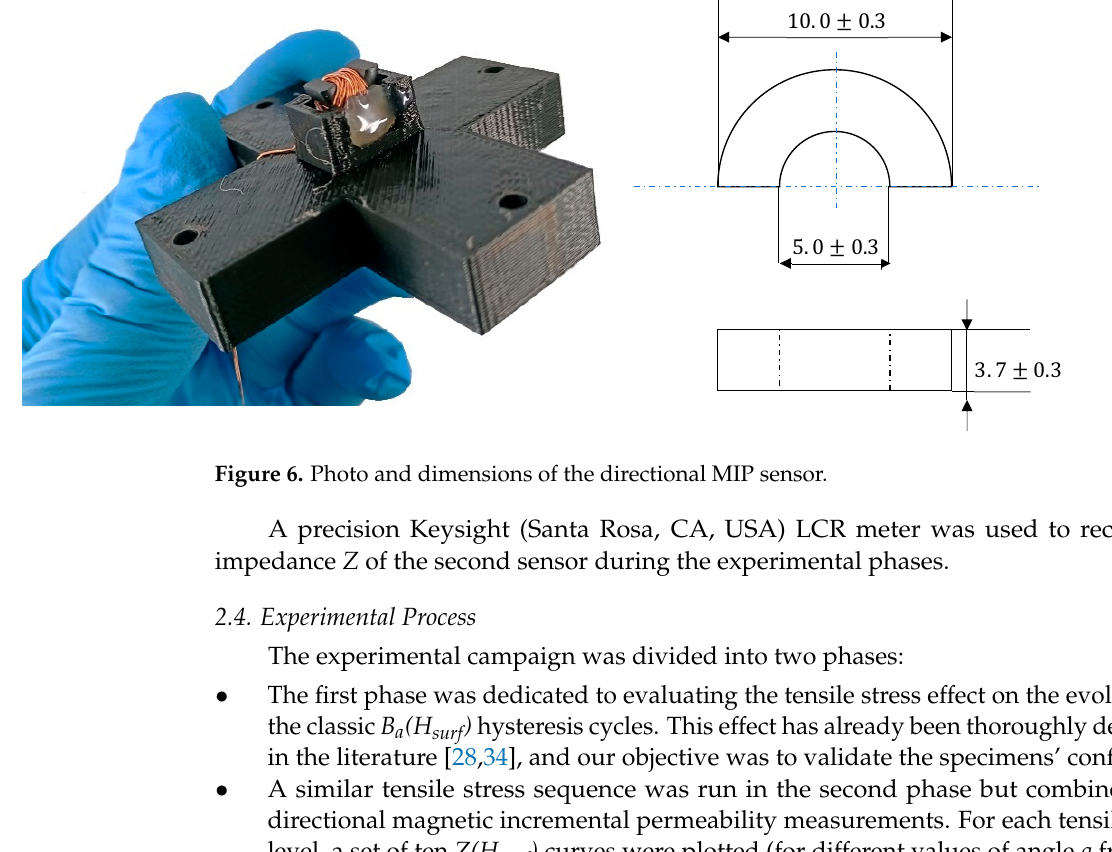
Figure 6. Photo and dimensions of the directional MIP sensor.